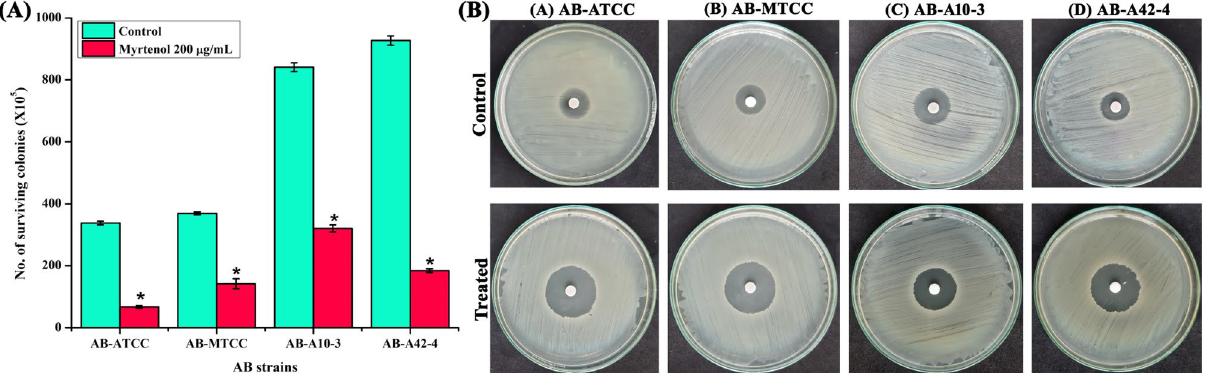
Figure 7. ( A ) Effect of myrtenol (200 μg/mL) on the survival of AB-ATCC 19606, AB-MTCC 9826, AB-A10-3 and AB-A42-4 in the presence of H 2 O 2 and ( B ) plate images showing the effect of myrtenol on the sensitivity of AB strains to H 2 O 2 by disc diffusion assays. Error bars and asterisks indicate the SD and statistical significance ( p < 0.05),